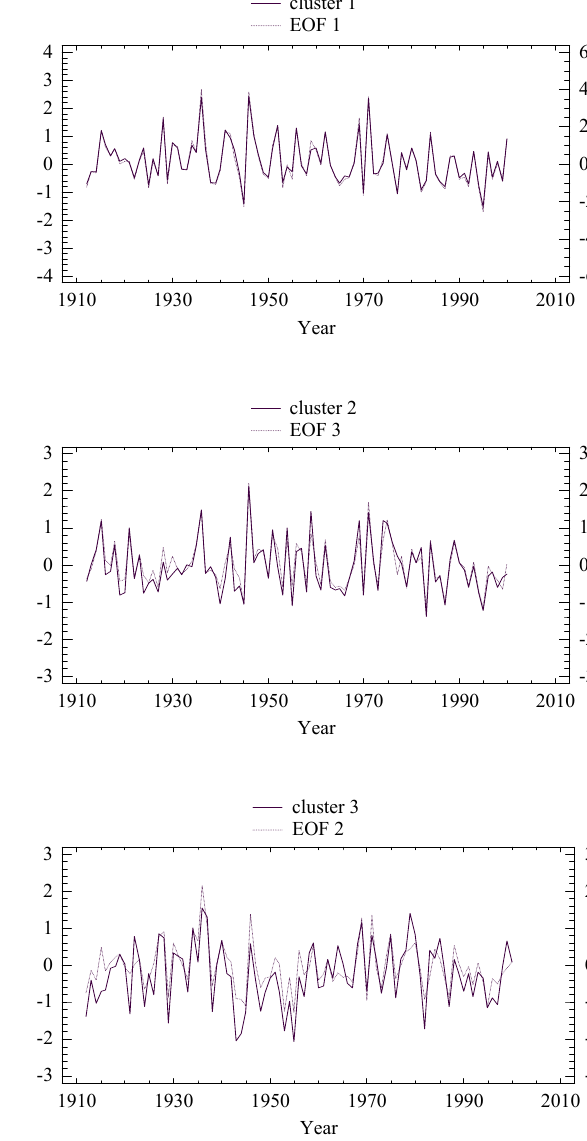
Fig. 10. Temporal evolution of the centroid series (left axis, contin- uous line) and principal component series (right axis, dashed line) for the period 1912–2000, corresponding to each cluster/EOF for winter.